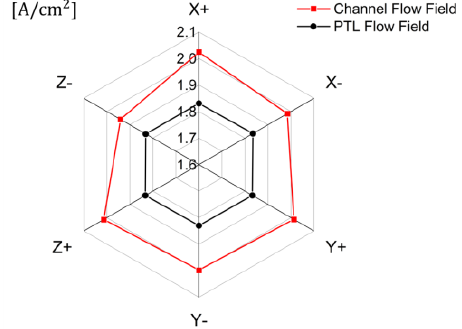
Figure 15. Effects of the gravity on current density with channel and PTL flow fields in PEMWE ( ε : 0.75, K : 30.2 × 10 −12 m 2 , θ : 30°, 𝑄̇ 𝑖𝑛 : 10 sccm, T in : 328.15 K, T cell : 328.15 K, V op : 1.8 V).